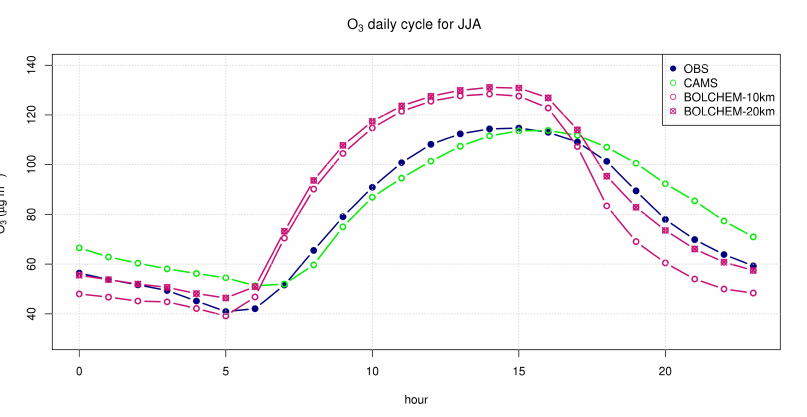
Figure 16. Hourly mean ozone concentration averaged overall background station for the summer season. Observations (blue curve) and modeled concentrations at 0.1 ◦ and 0.2 ◦ resolution (red curve for BOLCHEM model and green curve for CAMS ensemble) are